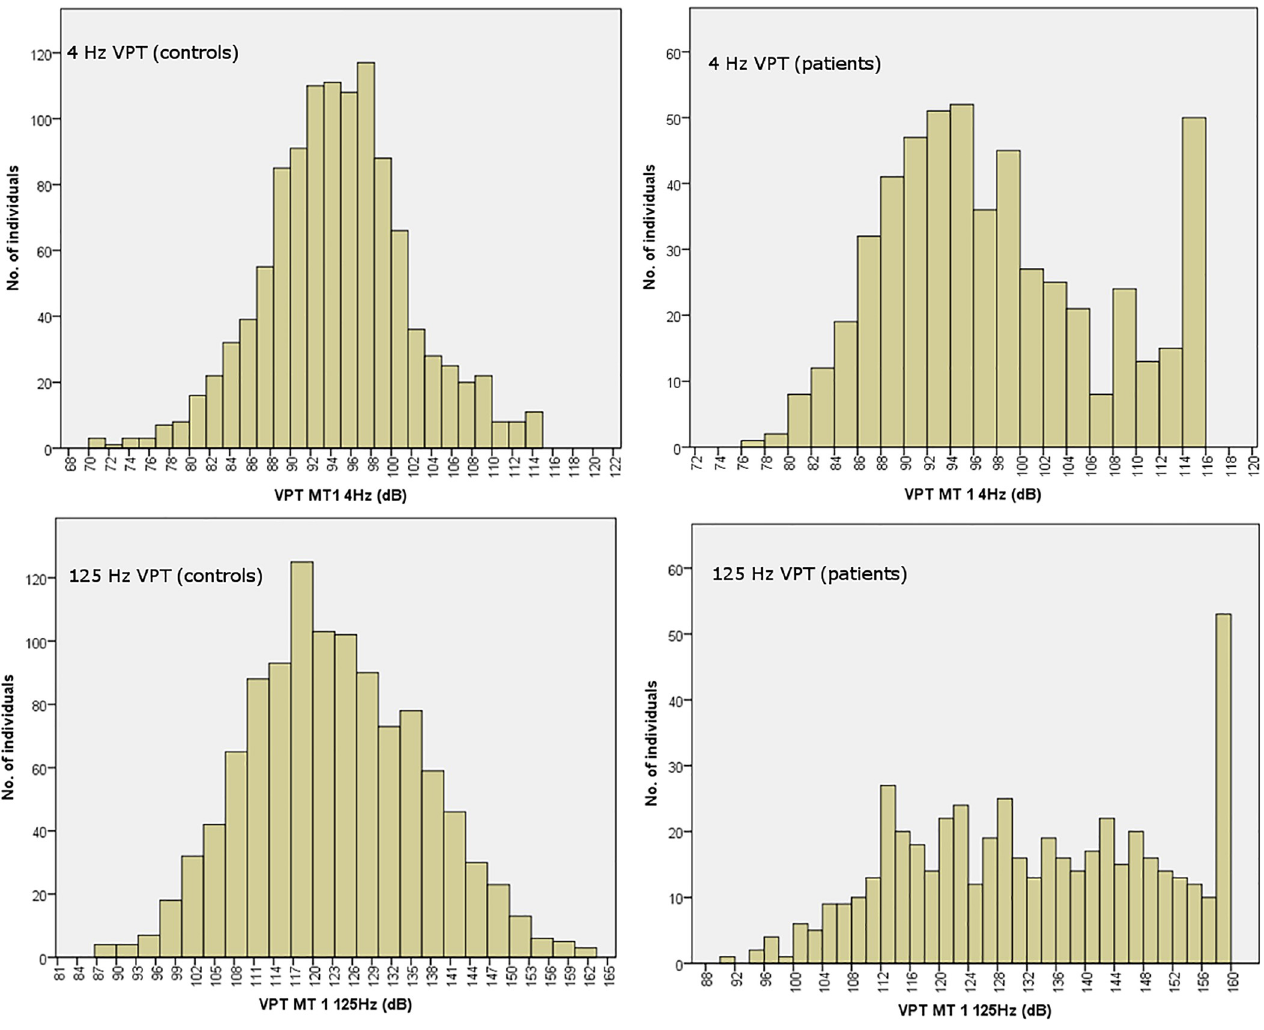
Fig 2. Distribution of VPTs in patients and in controls at 4 Hz and 125 Hz